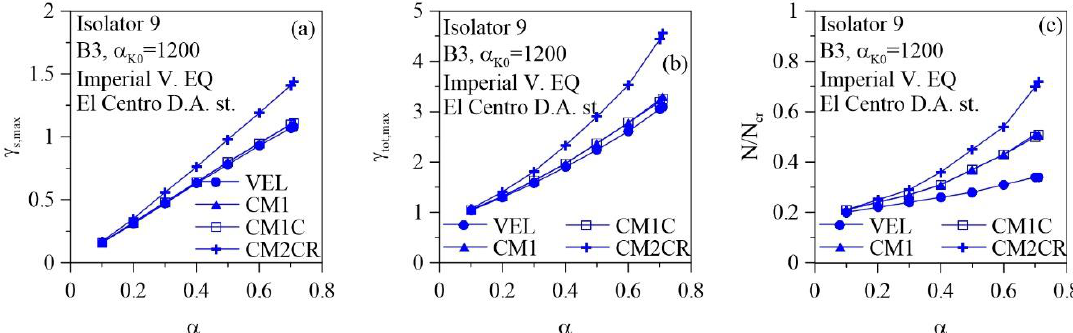
Figure 5. Response parameters of the base-isolation system for the B3 test structure subjected to the Imperial Valley EQ. ( a – c ) main parameters of the base-isolation systems.